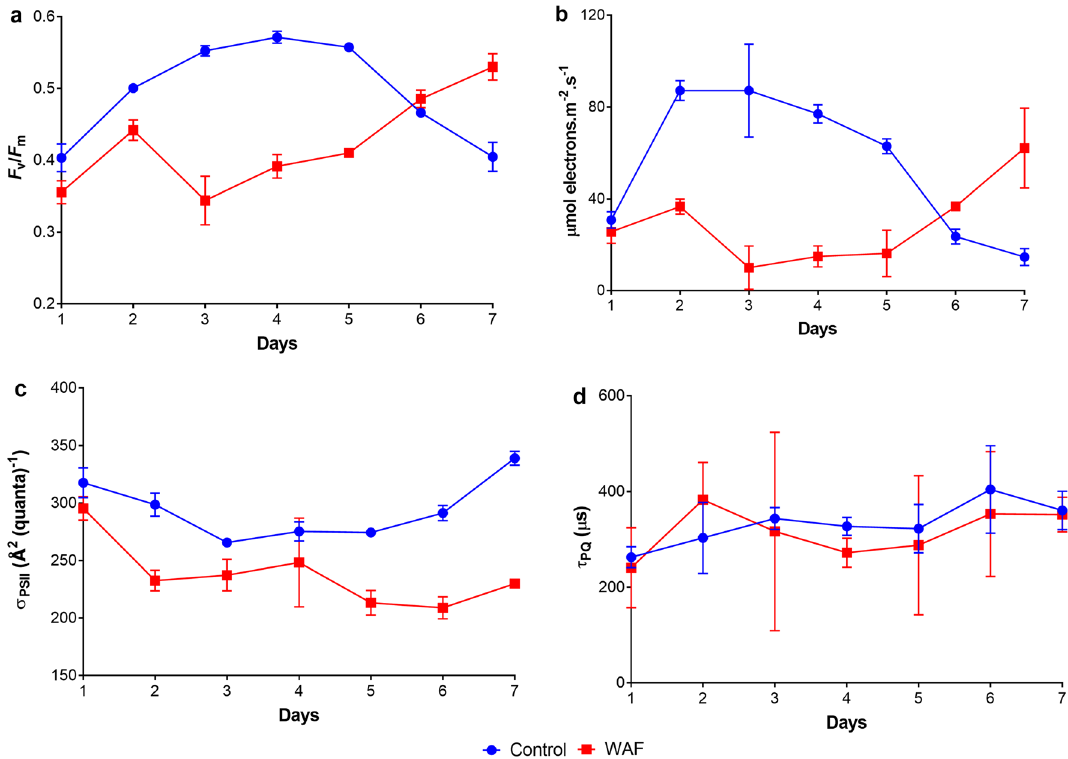
Figure 2. Photo-physiological response of T. pseudonana . ( a ) average maximum quantum yield of PS II ( F v / F m ), ( b ) average functional absorption cross-section area of PS II (σ PSII ; Å2 quanta –1 ), ( c ) average maximum electron transport rates ( r ETR max ; µmol electrons m −2 .s −1 ), and ( d ) average Q A turnover rates of plastoquinone (τ PQ ; µs) of T. pseudonana ( ±) under Control and WAF treatments (n =